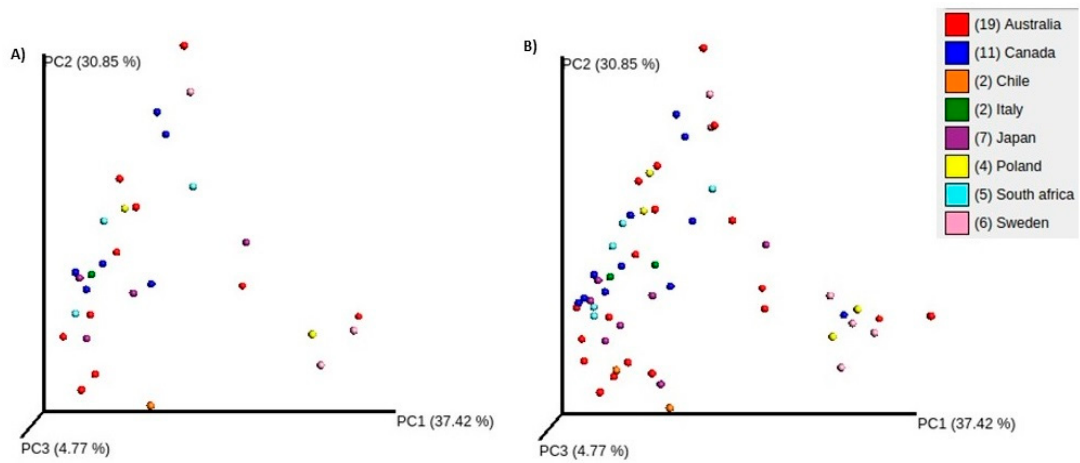
Figure 1. Principle component analysis of weighted UniFrac distances for the oral microbiomes of athletes at Baseline only (BL, A ); and when combined with their profiles obtained after the diet-training intervention period ( B ). Samples are colored based on the athlete’s country of origin and show no significant clustering indicative of a dietary and/or ethnic effect on the oral microbiomes.